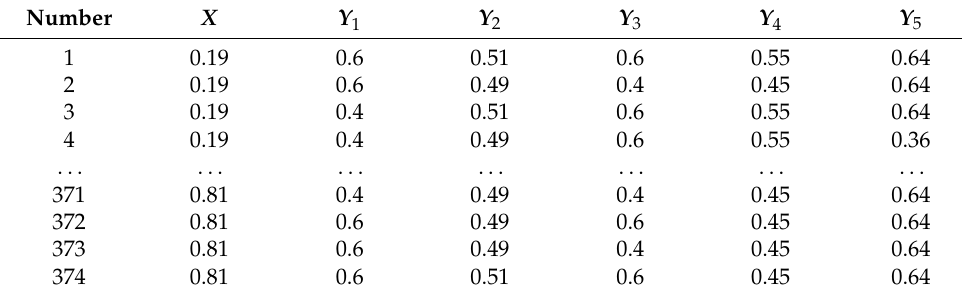
Table A2. Quantitative results of experimental data in study 4.